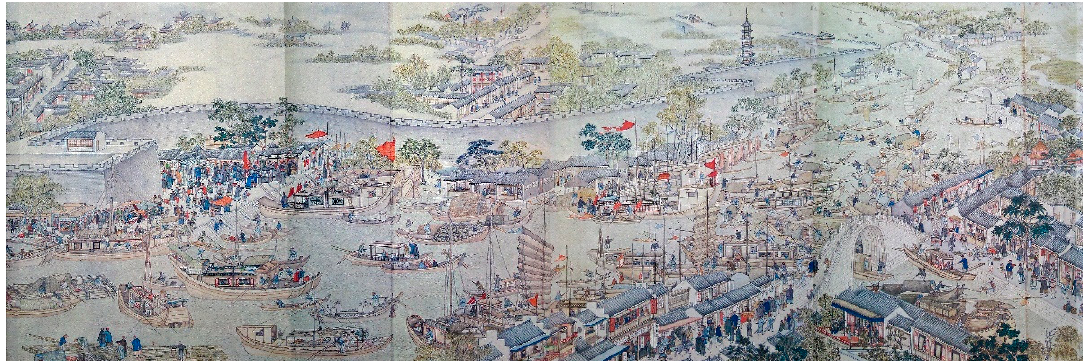
Figure 11. Scene of the canals around Pan Gate described in Suzhou’s Golden Age [65].